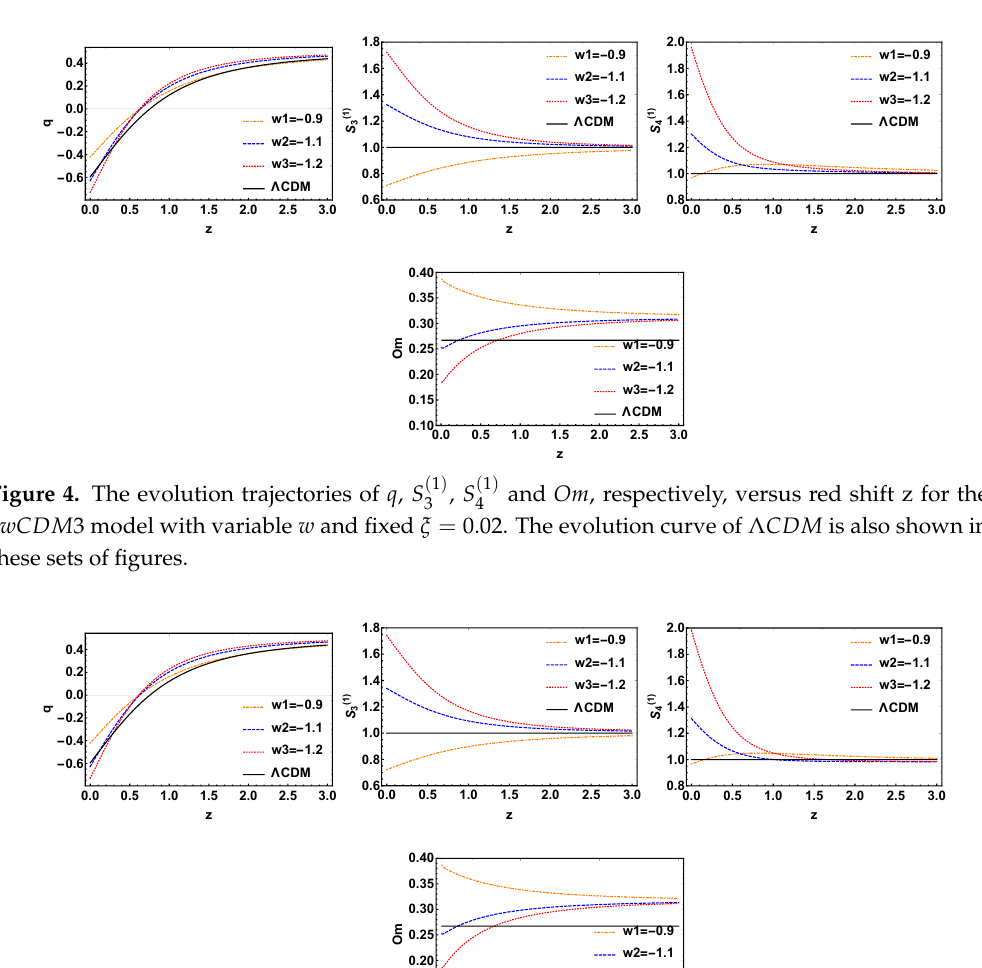
Figure 5. The evolution trajectories of q , S IwCDM 4 model with variable w and fixed ξ = 0.02. The evolution curve of Λ CDM is also shown in these sets of figures.